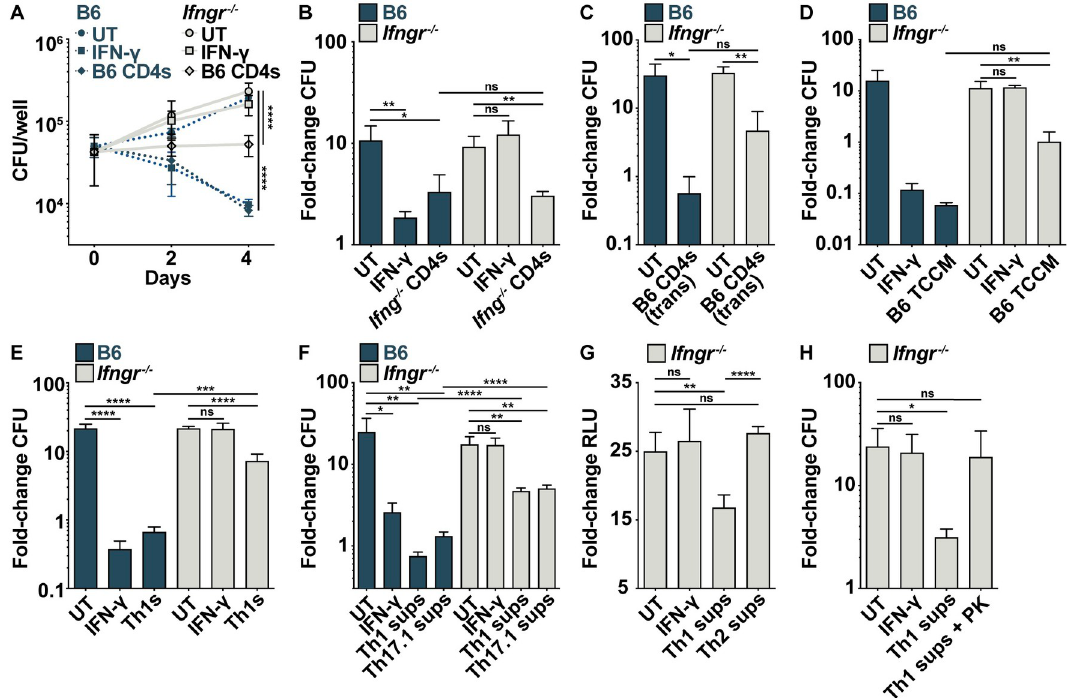
Fig 1. Lung-derived and in vitro -differentiated CD4 T cells control M . tuberculosis growth independent of IFN- γ . ( A ) CFU/well at d 0, 2 and 4 postinfection for wild-type and Ifngr -/- BMDMs co-cultured with lung-derived CD4 T cells. ( B ) CFU fold-change at d 5 postinfection for wild-type and Ifngr -/- BMDMs co-cultured with lung-derived Ifng -/- CD4 T cells. ( C ) CFU fold-change at d 4 postinfection for wild-type and Ifngr -/- BMDMs cultured with lung-derived CD4 T cells in transwells. ( D ) CFU fold-change at d 5 postinfection for wild-type and Ifngr -/- BMDMs treated with conditioned media from lung-derived CD4 T cells (T cell conditioned media, TCCM). ( E ) CFU fold-change at d 5 postinfection for wild-type and Ifngr -/- BMDMs co-cultured with in vitro differentiated Th1 cells. ( F ) CFU fold-change at d 4 postinfection for wild-type and Ifngr -/- BMDMs treated with Th1 or Th17.1 supernatants (sups). ( G ) RLU fold-change at d 5 postinfection for Ifngr -/- BMDMs treated with Th1 or Th2 sups. ( H ) CFU fold-change at d 5 postinfection for Ifngr -/- BMDMs treated with Th1 sups +/- Proteinase K (PK). Figures are representative of two (H) or three or more (A)-(G) experiments. Error bars are SD from four (A)-(B), (D)-(H) or three (C) replicate samples, � p < 0.05, �� p < 0.01, ��� p < 0.001, ���� p < 0.0001 by unpaired